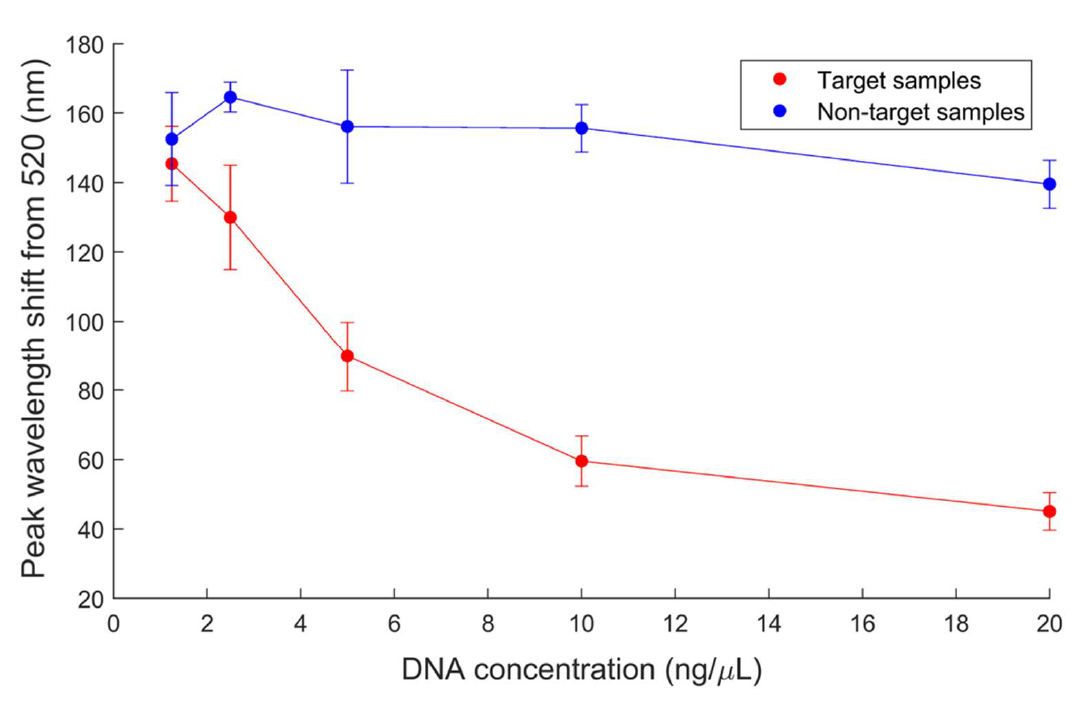
Figure 7. Target ( E. coli O157) and non-target ( Listeria spp.) peak wavelength shift from 520 nm at varying concentrations, 1.25-20 ng/µL. Error bars represent 95% confidence intervals of 9 replicates.